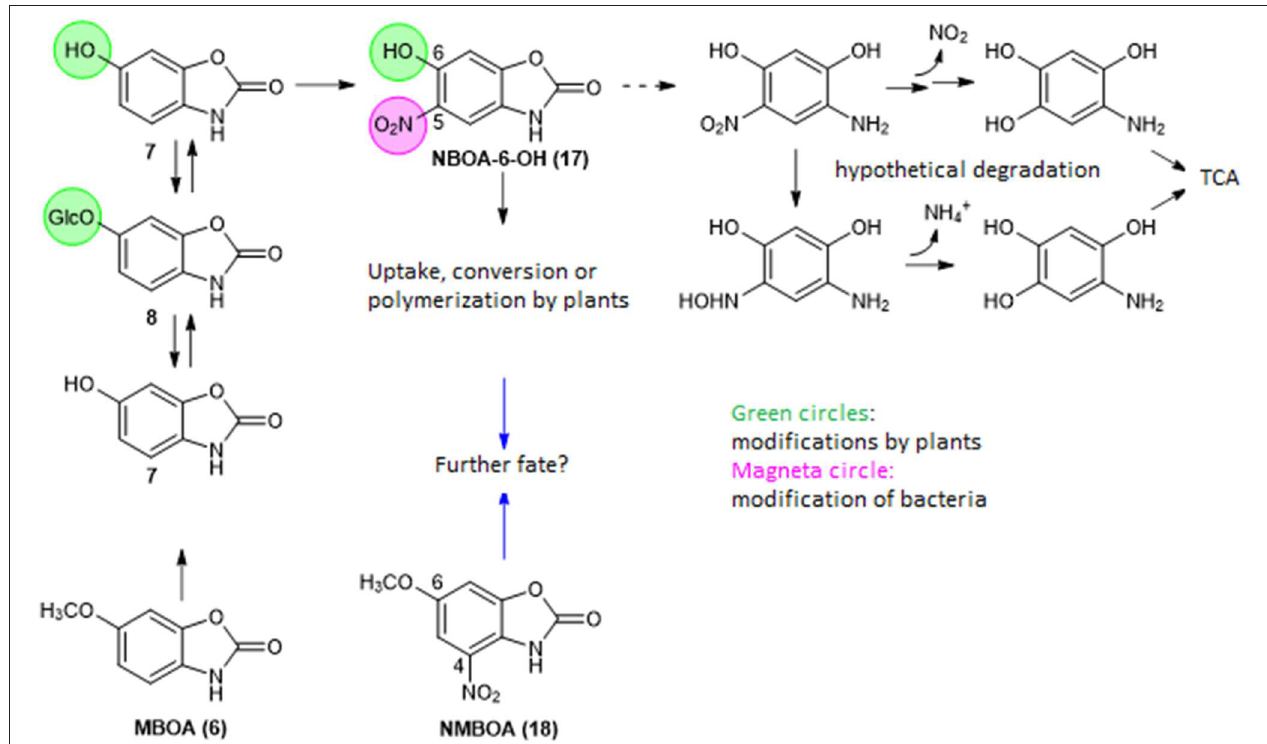
FIGURE 7 | Pathway A for BOA-6-OH and MBOA nitration.